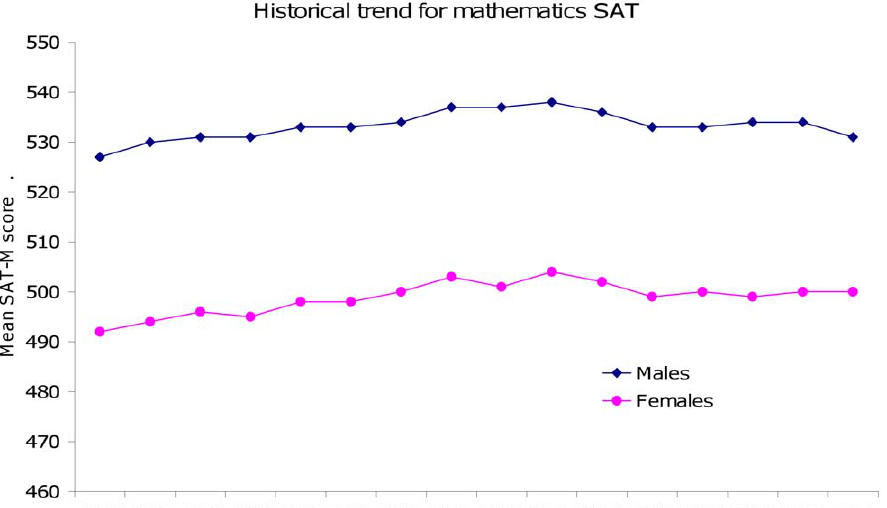
Figure 1. Gender differences in SAT-M performance. On average, boys score higher than girls on the SAT-M exam (approximately one third of a standard deviation). The pattern of scores is consistent across years and does not appear to be diminishing, contrary to other lines of evidence that show gender differences in mathematics are small [51].